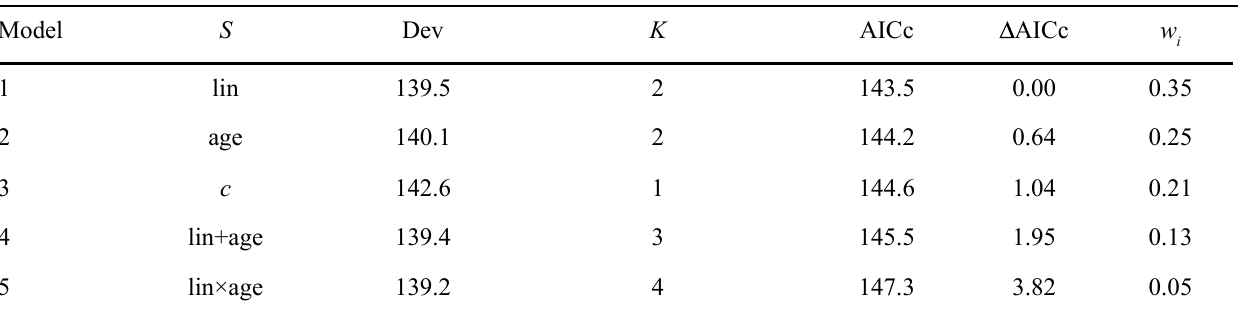
Table 1. Comparison of nest survival models examining the survival of nests of Greater Prairie-Chickens ( Tympanuchus cupido ) in northeast Kansas between 2003 to 2005 ( n = 34). Table abbreviations are as follows: S = parameters included in the survival model; Dev = deviance; K = number of parameters; AICc = Akaike’s Information Criterion corrected for small sample sizes; AICc = difference of the AICc value in the given model compared to the minimum AICc model; and w = Akaike weights. Model factors are as i follows: lin = linear time; age = nest age; c = constant; × = interaction; and + = main effects model. Model S Dev K AICc